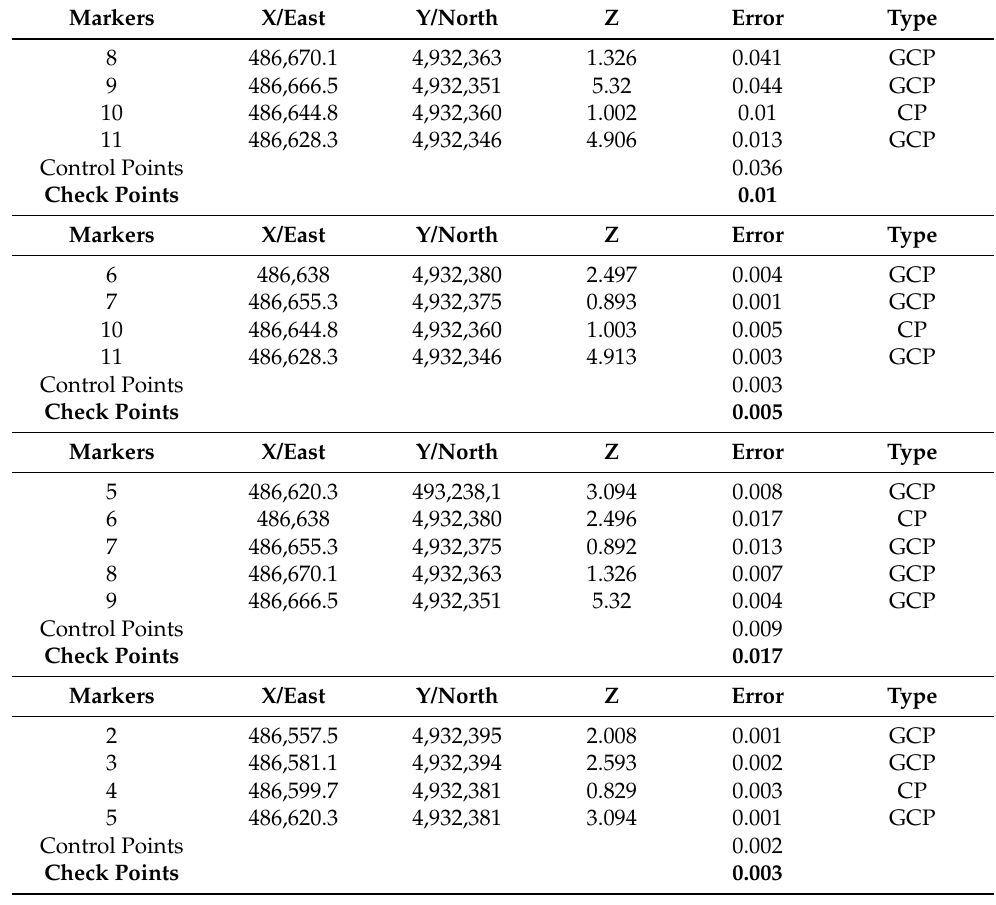
Table 2. GCPs and CP error over each dataset. Tables are ordered consecutively (datasets 1–4) from top to bottom. The coordinates are provided in WGS84/UTM32N. The errors are computed by Agisoft Metashape based on bundle block